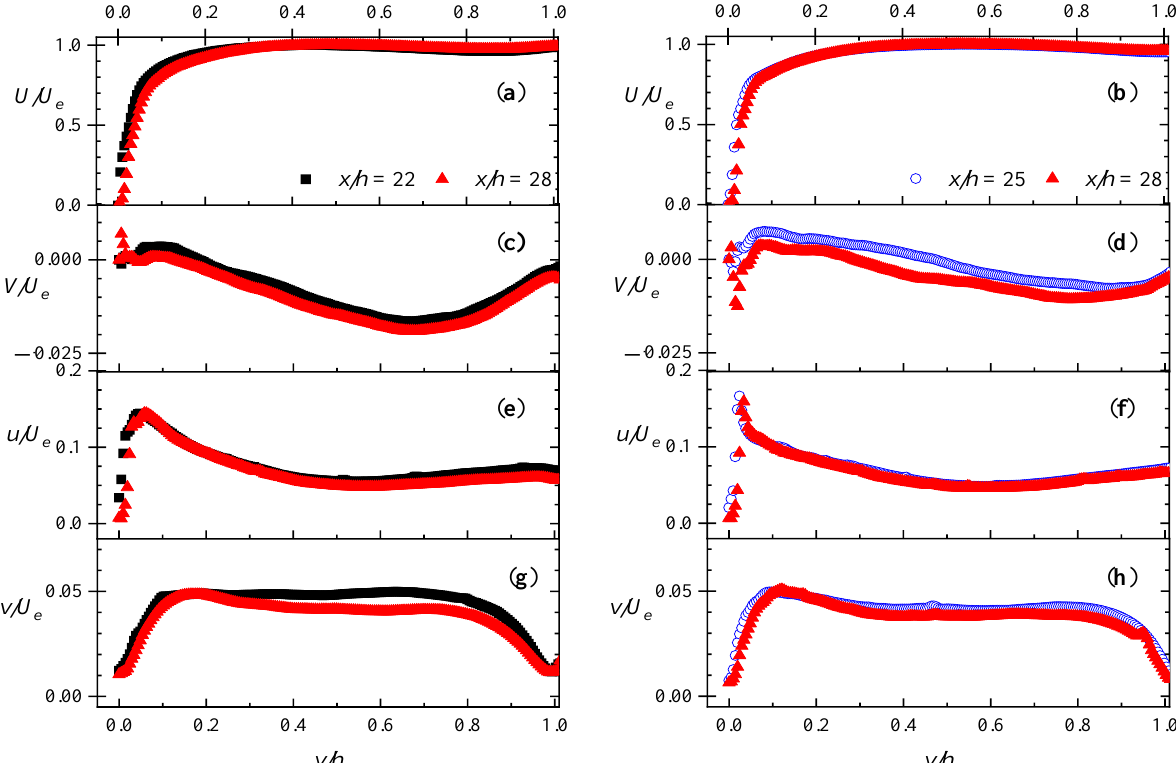
Figure 2. Wall-normal variations of streamwise mean velocities ( a , b ), wall-normal mean velocities ( c , d ), streamwise turbulence intensities ( e , f ), and wall-normal turbulence intensities ( g , h ). These profiles are extracted at x/h = 22, 28 for test condition AR 1.5 Re 165 Fr 0.13 (shown in ( a , c , e , g ) and x/h = 25, 28 for test condition AR 1.3 Re 452 Fr 0.17 (shown in ( b , d , f , h )). All velocities are normalized by the local maximum velocity, and the lengths are normalized by the respective depth of the flow.